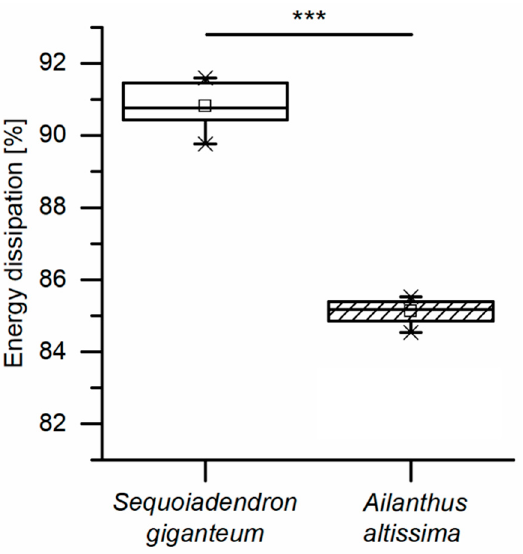
Figure 5. Energy dissipation of bark samples of S. giganteum and A. altissima during dynamic drop-weight tests (statistical test: t-test; n = 10 for S. giganteum , n = 8 for A. altissima ). Significant differences are marked by asterisks, with the levels of significance indicated as follows: *** p < 0.001.